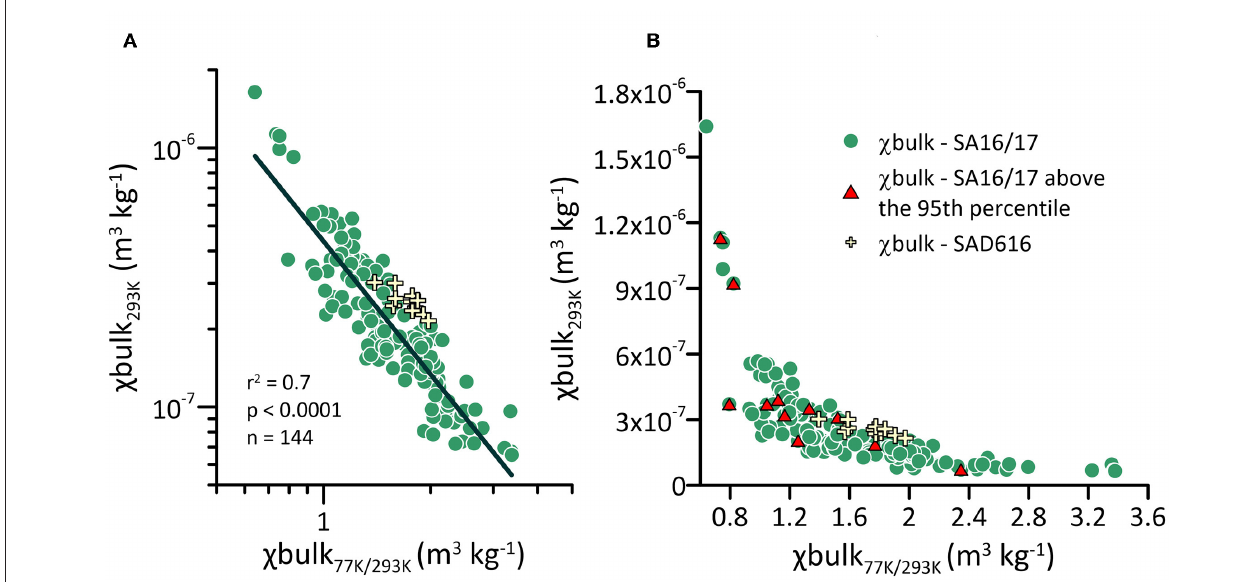
FIGURE 4 | (A) χ bulk 293K vs. χ bulk 77K over χ bulk 293K on a log scale. The strong correlation between the two variables suggests that the strength of magnetic susceptibility (MS) is related to the concentration of magnetic carriers. (B) The same plot as A, but on a regular scale. All χ bulk samples are plotted. The samples identified above the 95th rate-of-change (ROC) percentile are represented by red triangles. Samples from SAD616 are shown as a pale yellow crosses. Both datasets plot along the SA16/17 dataset (green